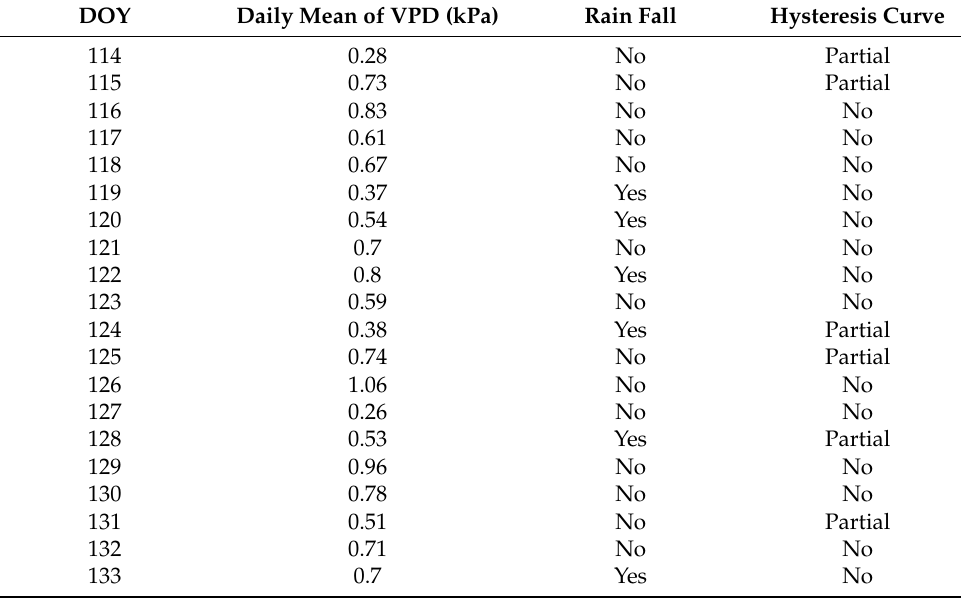
Table 2. Data of daily mean VPD and rainfall for